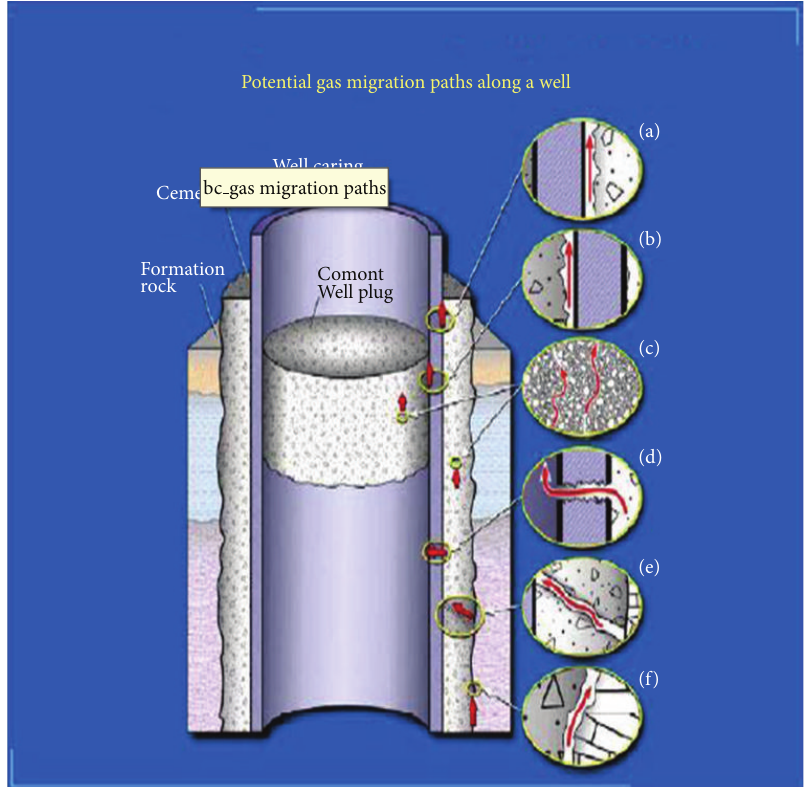
Figure 1: Illustration of migration along the path (figure from Alberta Energy Utilities Board) [14].